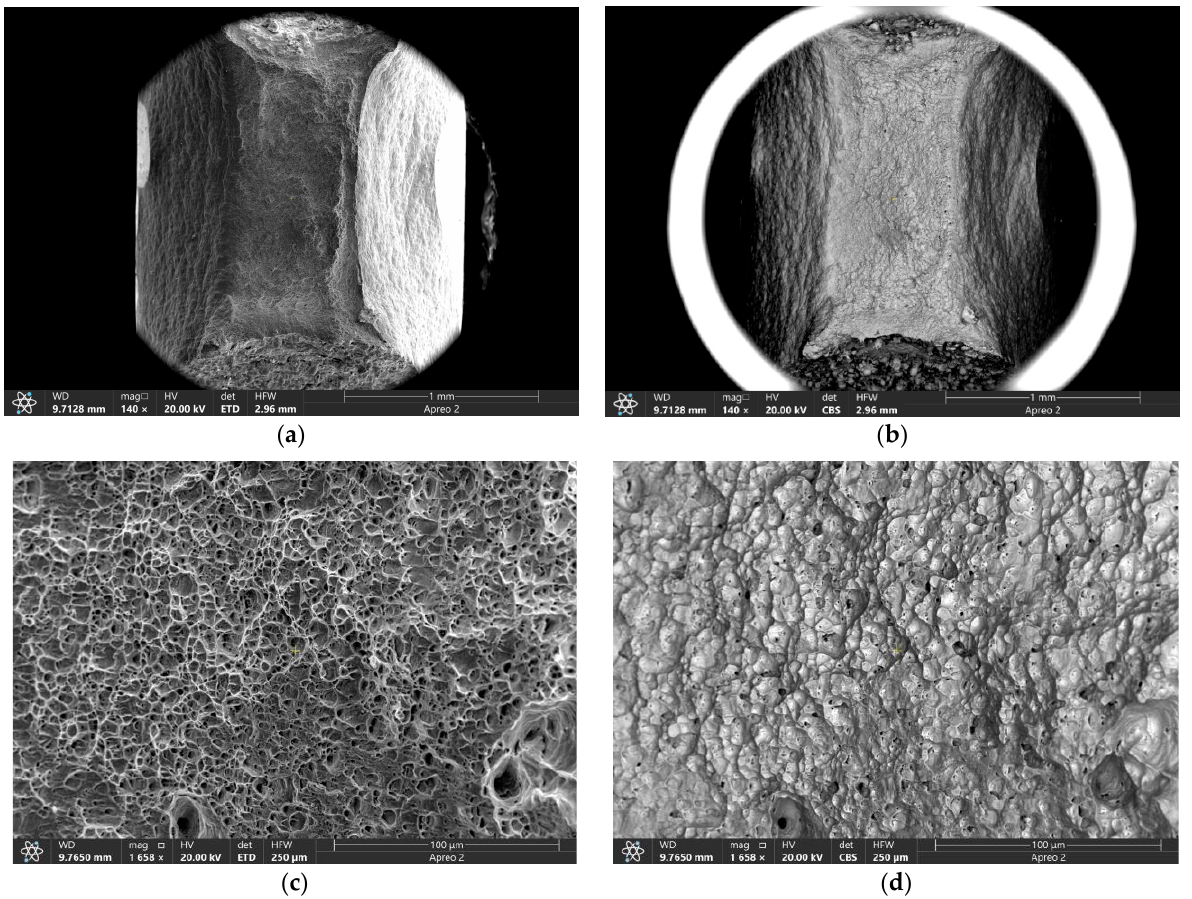
Figure 22. SEM SE ( a , c ) and BSE ( b , d ) images of the fracture surface “ copper − steel ” sample after tensile testing.